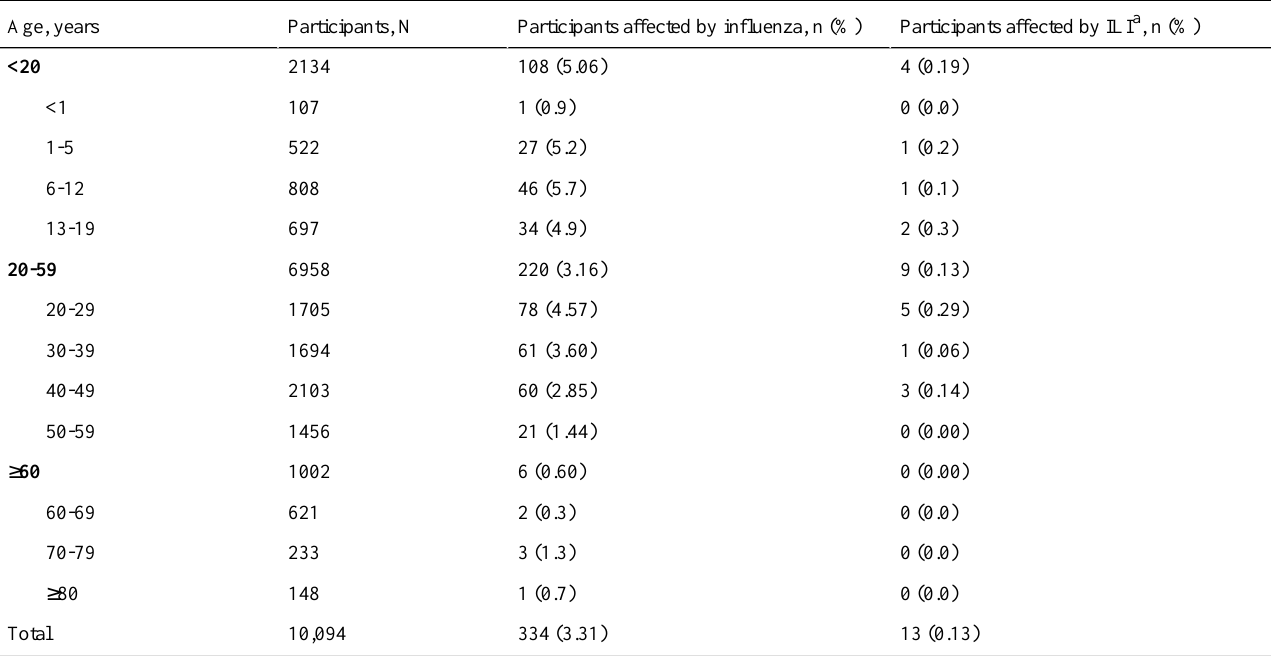
Table 1. Influenza morbidity ratios for study participants based on Flu-Report. All data were drawn from Flu-Report as entered by participants in this study.